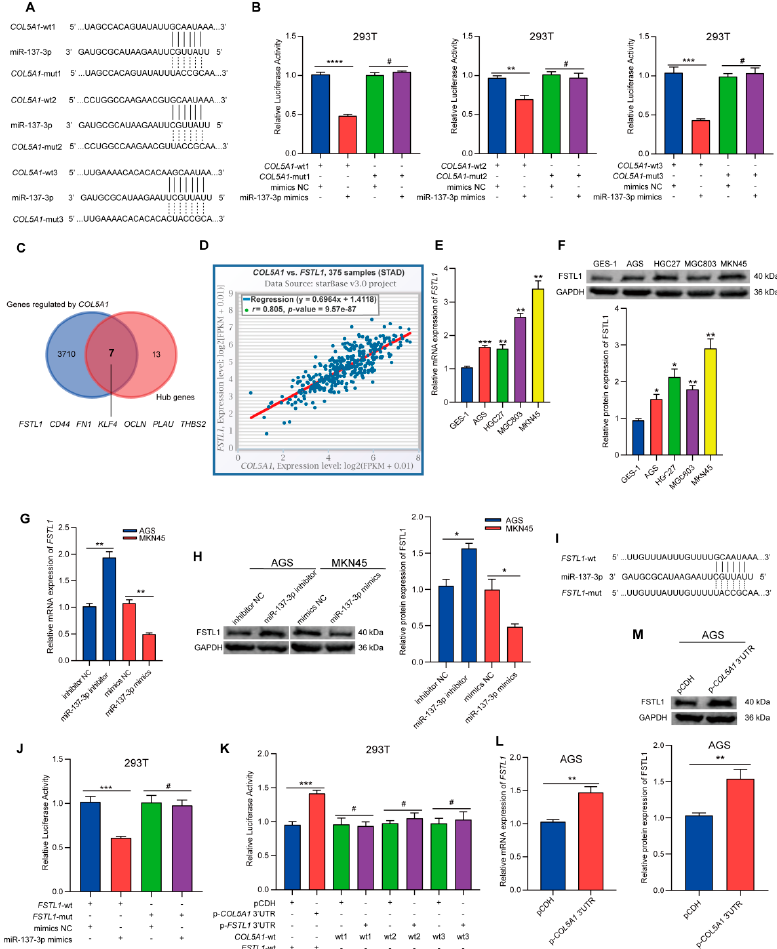
Figure 4. COL5A1 regulated FSTL1 by competitive binding to miR-137-3p through a ceRNA mechanism. ( A ) Construction of the COL5A1-wt/mut luciferase plasmid for 3 binding sites of miR- 137-3p. ( B ) Dual-luciferase reporter assays were conducted to verify the binding between miR-137- 3p and COL5A1. ( C ) The intersection of genes regulated by COL5A1 (blue) and the hub genes (red). ( D ) Correlation analysis of COL5A1 and FSTL1 in GC from TCGA. The expression level of FSTL1 was assessed by qRT-PCR ( E ) and Western blotting ( F ). qRT-PCR ( G ) and Western blotting ( H ) were performed to detect the mRNA and protein levels of FSTL1 after transfection with miR-137-3p mimics or inhibitor. ( I ) Construction of the FSTL1-wt/mut luciferase plasmid for the binding site of miR-137-3p. Dual-luciferase reporter assays were conducted to verify the binding between miR-137- 3p and FSTL1 ( J ) and to confirm that the COL5A1 3 ′ UTR could competitively bind miR-137-3p ( K ). The expression level of FSTL1 was assessed by qRT-PCR ( L ) and Western blotting ( M ) after transfection with the COL5A1 3 ′ UTR in AGS cells. Full uncropped figures of Western blotting can be found in Supplementary File S5. Data are presented as mean ± SD of three independent experiments. # p > 0.05; * p < 0.05; ** p < 0.01; *** p < 0.001; **** p < 0.0001. To verify this hypothesis, we detected the expression level of FSTL1 in GES-1 and four GC cell lines. As expected, we found that the expression of FSTL1 was highly consistent with COL5A1, that is, it was also high in MKN45 cells with high COL5A1 expression and low in AGS cells with low COL5A1 expression (Figure 4E,F). Moreover, the expression of FSTL1 increased after transfection of miR-137-3p inhibitor in AGS and decreased after transfection of miR-137-3p mimics in MKN45, indicating that the expression of FSTL1 was also regulated by miR-137-3p (Figure